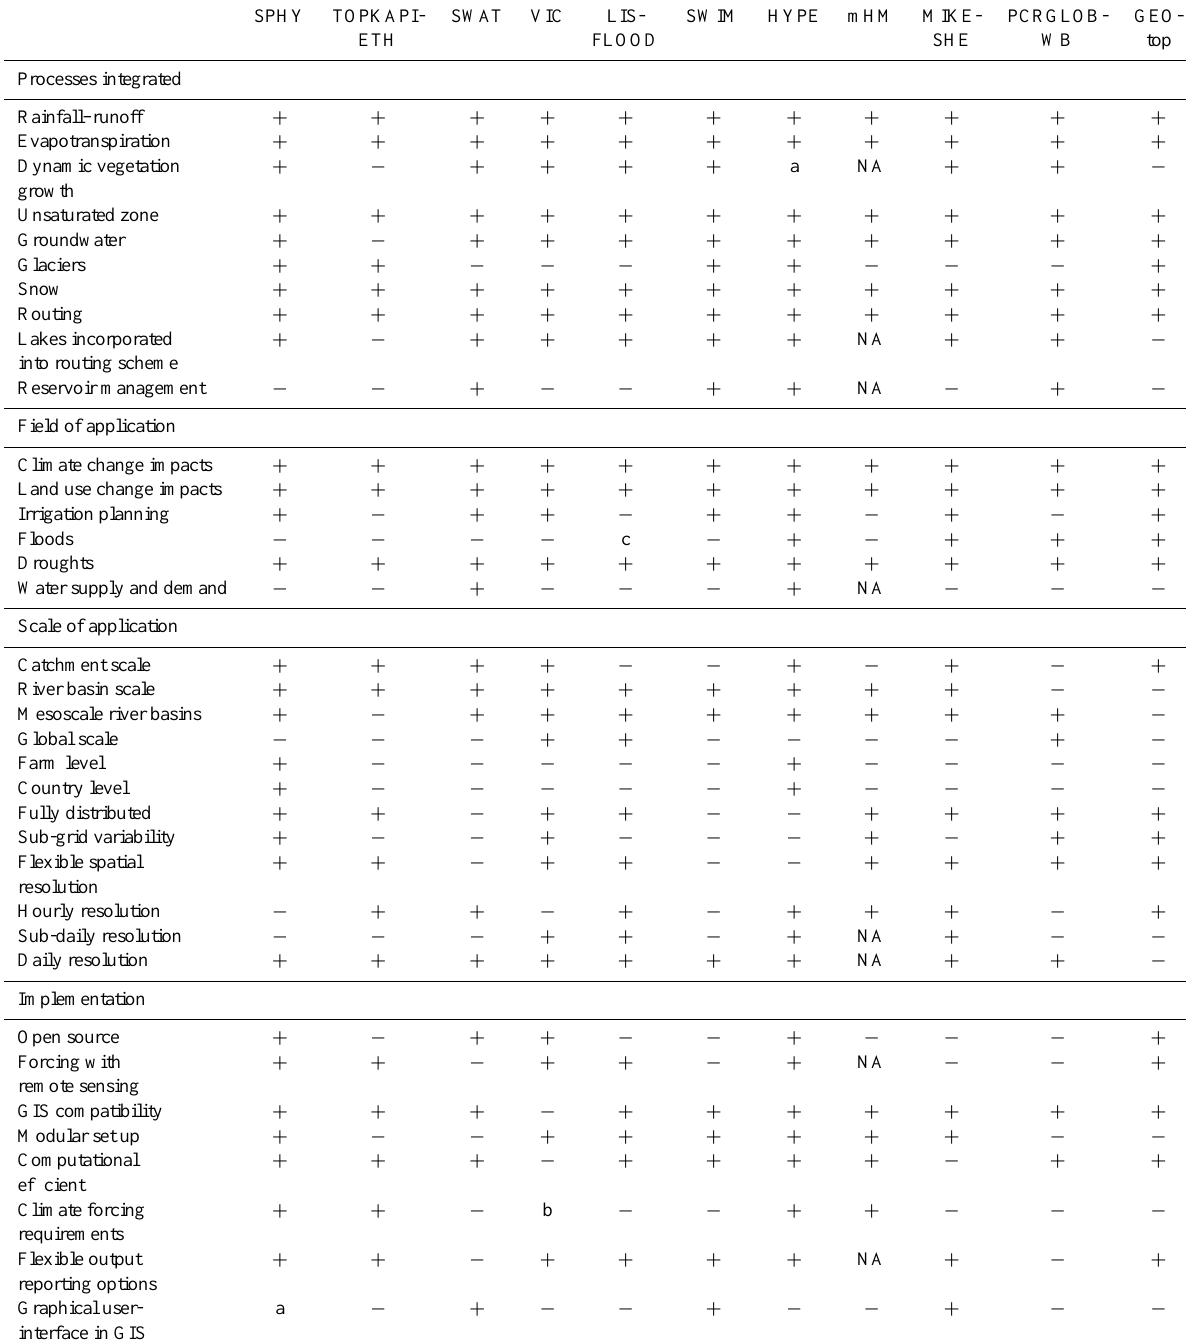
Table 1. Pros ( + ) and cons ( − ) of some well-known hydrological models, including the SPHY model. A categorization is made between (i) processes that are integrated, (ii) field of application, (iii) scale of application, and (iv) implementation. SPHY TOPKAPI- SWAT VIC LIS- SWIM HYPE mHM MIKE- FLOOD SHE WB top